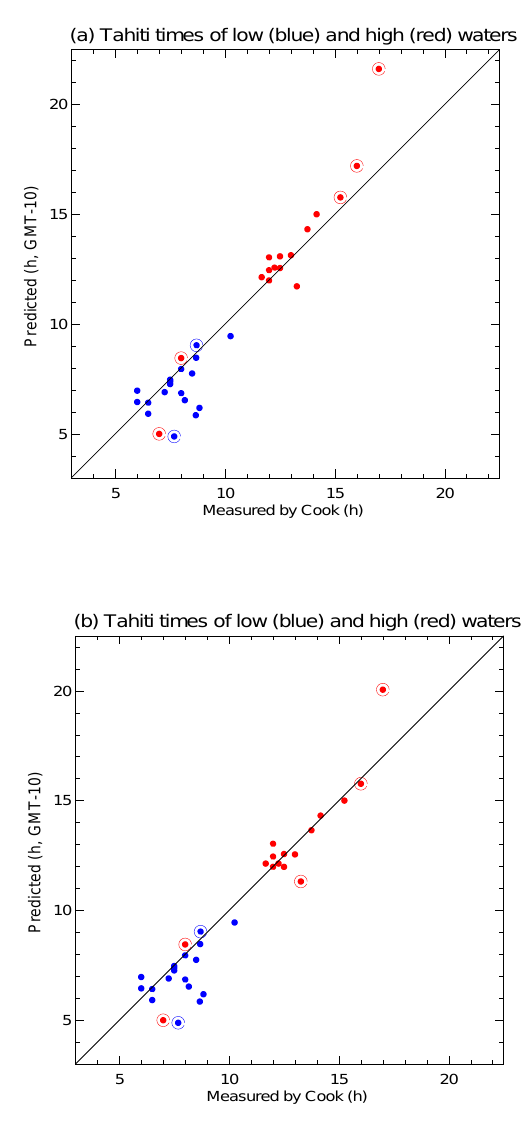
Figure 4. (a) Times of day of high (red) and low (blue) waters measured at Matavai Bay, Tahiti, by Cook and as predicted using modern tidal constants for Papeete, assuming the dates in Cook and Green (1771) had been reported using the civil day. Points with a circle indicate small predicted tides within 7.5cm of mean sea level. (b) As (a) but assuming the dates were reported using the naval day (ship time). Note that the change between civil and naval day results in a different association of Cook times and predicted values, and as a result the set of encircled points in (a) and (b) is not exactly the